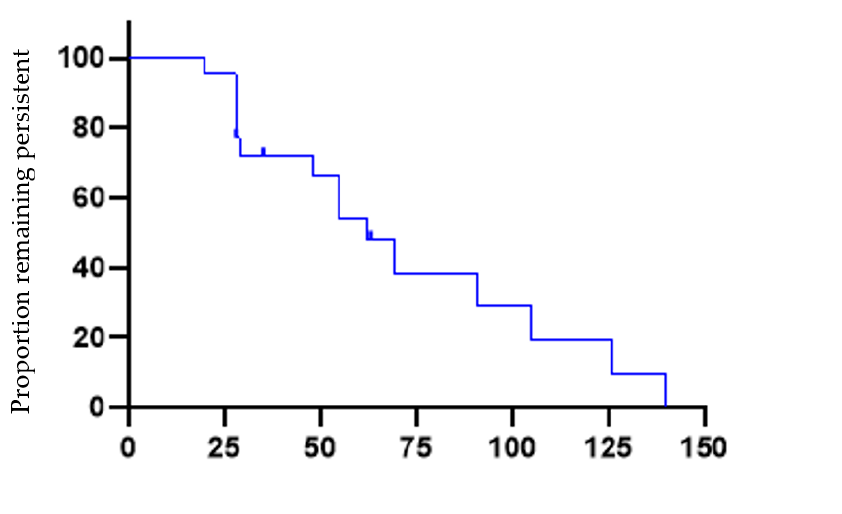
Figure 3. Loss of anti-N IgG persistence among 22 young adults. Decline in positive N-IgG status over 140 days ( n = 22), between participant’s initial date of enrollment in fall semester 2020 until 31 March 2021. 68.1% had decline of N-IgG over 140 days. X -axis is days between 0 to 140 days of N-IgG persistence by end of follow-up. Y -axis is proportion of people remaining with IgG persistence. Seven (censored) had persistent detectable N-IgG; fifteen did not. Persistence is defined as number of days between first positive and last positive IgG nucleocapsid result. This graph does not reflect number of days between date of first positive PCR test positive and date of first IgG positive. One observation in Table 1, column 3 was excluded from Figure 3 due to withdrawal from participation in September 2020.